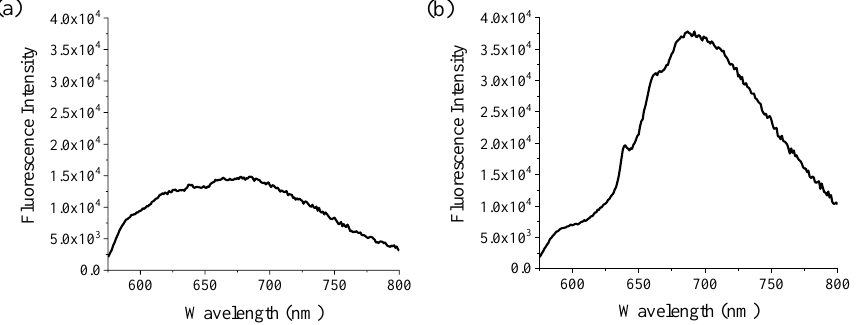
Figure 3. Emission spectra ( λ ex = 560 nm) for ( a ) NV-40 and ( b ) NV-90 NDs (0.1 mg/mL water). An emission filter was used to block emission below 590 nm to counteract the effects of light scattering.